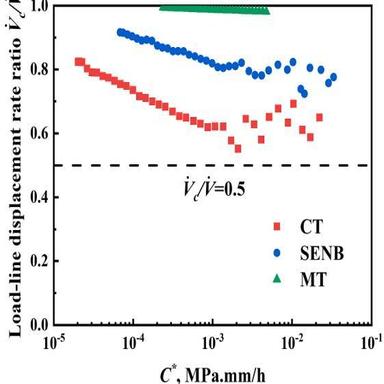
The values of V˙ c/V ˙ for CT, SENB and MT specimens with a homogeneous material during the CCG process.